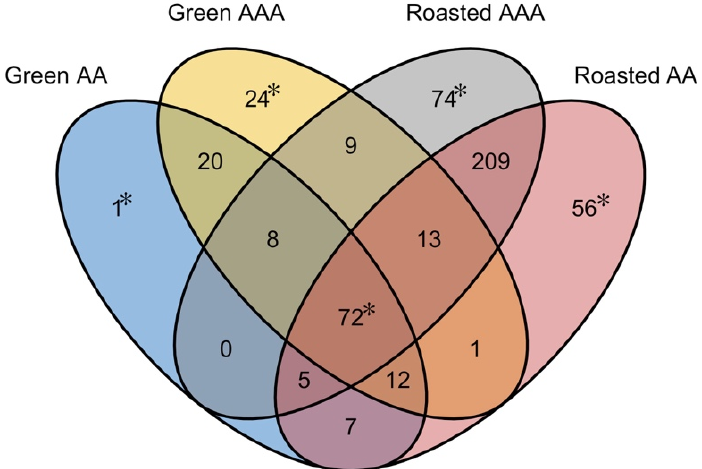
Figure 4. Venn diagram showing the commonality of identified compounds. Shared compounds are indicated in the overlapping areas of each oval; for example, 112 compounds were found common between the Green AAA and Green AA, which is determined by adding 20, 8, 72, and 12. Sets labeled with “*” are listed in Table 1 − 3.